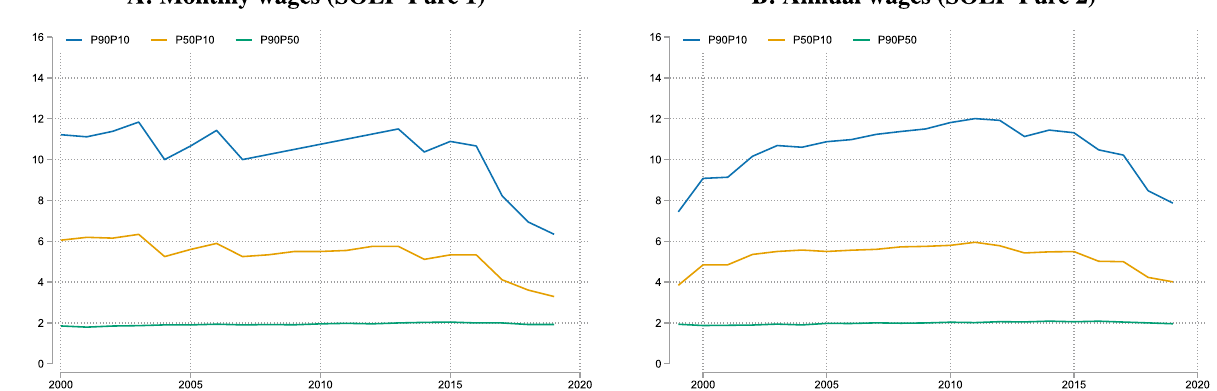
Fig. 1 Development of wage percentiles ratios in the SOEP 2000–2019. Source: own calculations,